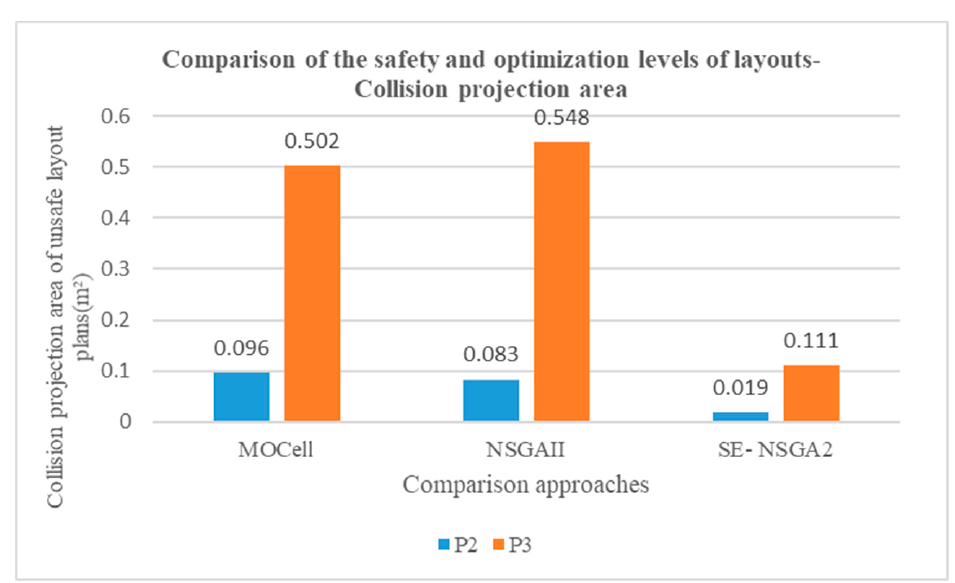
Figure 6. Comparison of the safety and optimization levels of layouts.